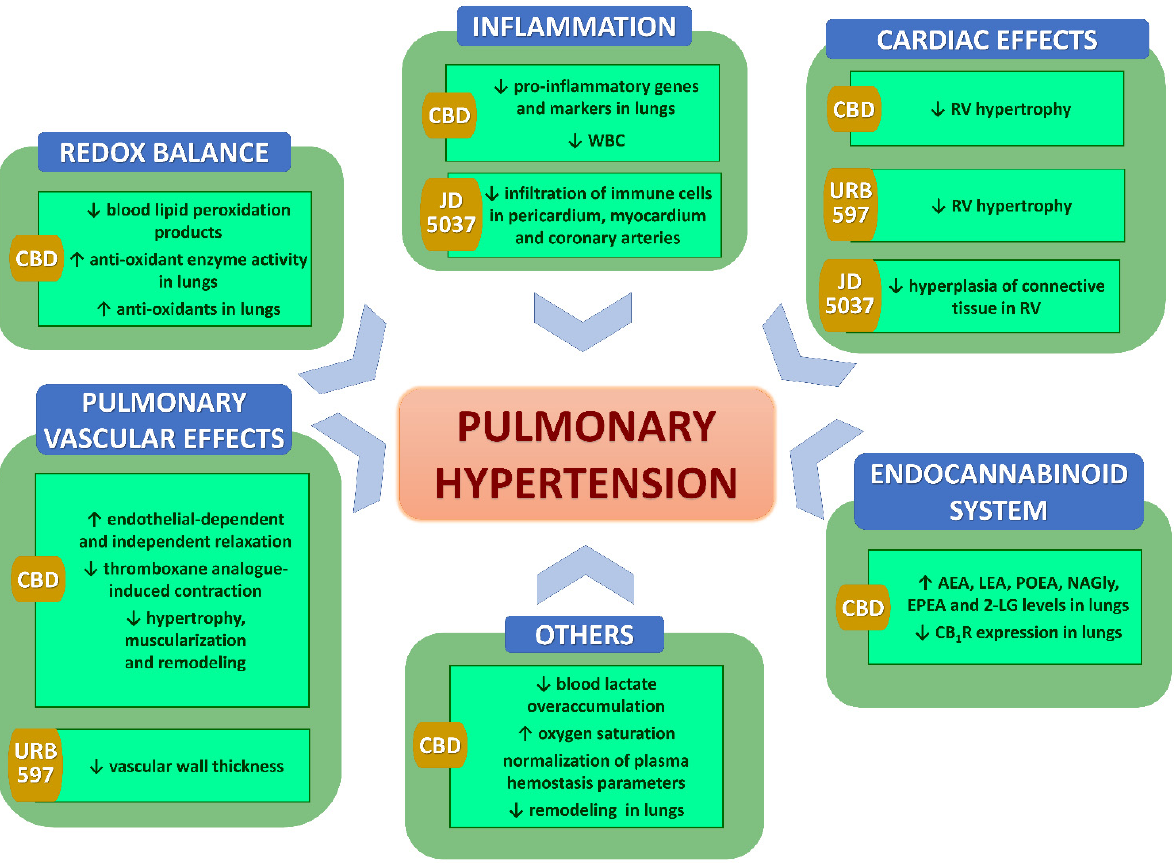
Figure 3. Summarized effects of (endo)cannabinoids on pulmonary hypertension. For clarity, the